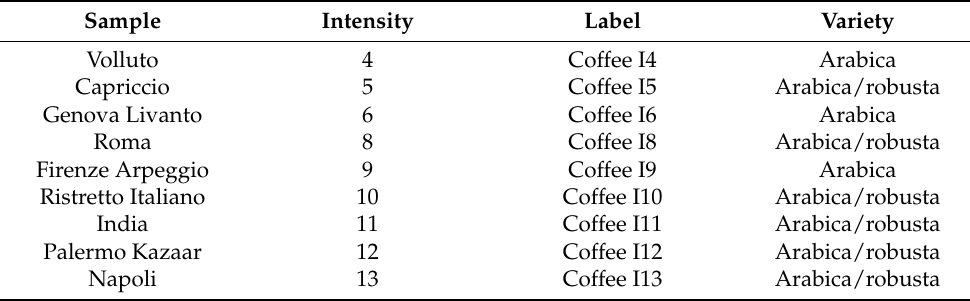
Table 1. Samples used for the study, including their specifications and labels.